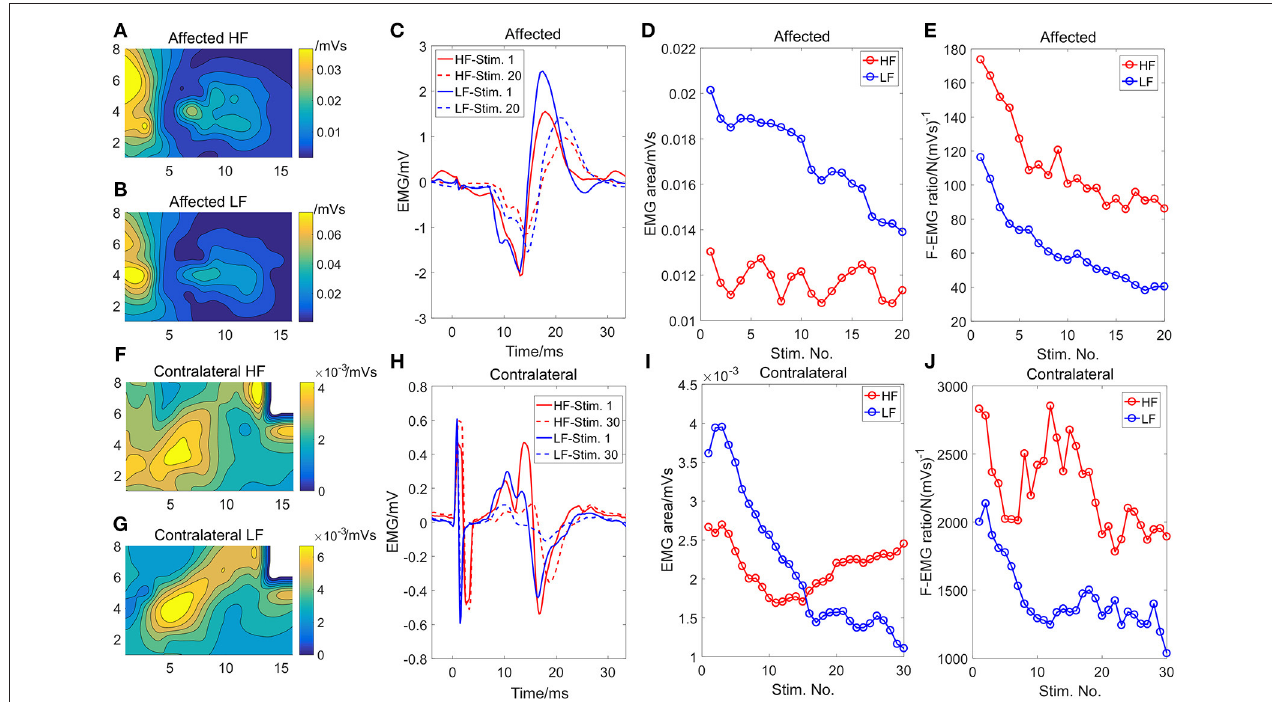
FIGURE 3 | The initial (first stimulation train) strength distribution of the EMG activity under the HF (A) and the LF (B) stimulation, respectively, on the affected side. The initial strength distribution of the EMG activity under the HF (F) and the LF (G) stimulation, respectively, on the contralateral side. The white area in (F) and (G) was eliminated from analysis because of motion artifact contamination. The EMG activity of the channel with the maximum EMG area on the affected (C) and the contralateral sides (H) , respectively. Only the EMG activity of the first and the last stimulation train were illustrated. The changes of the EMG area with the successive stimulation trains for the affected (D) and contralateral sides (I) , respectively. The changes of the F-EMG ratio with the successive stimulation trains for the affected (E) and the contralateral sides (J) ,